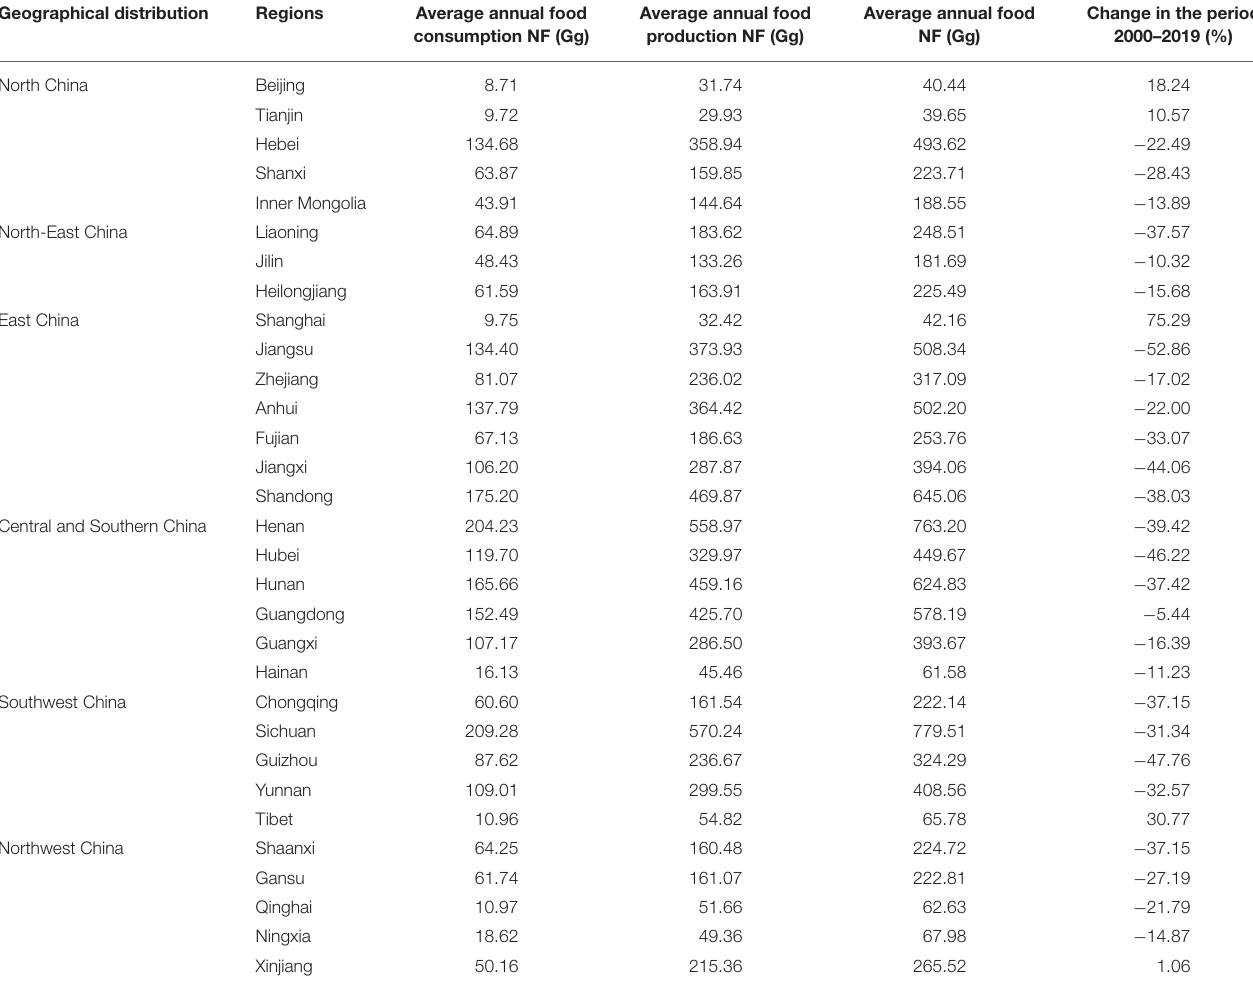
TABLE 2 | Average regional food nitrogen footprints (NFs) of food production and consumption in rural areas from 2000 to 2019. Geographical